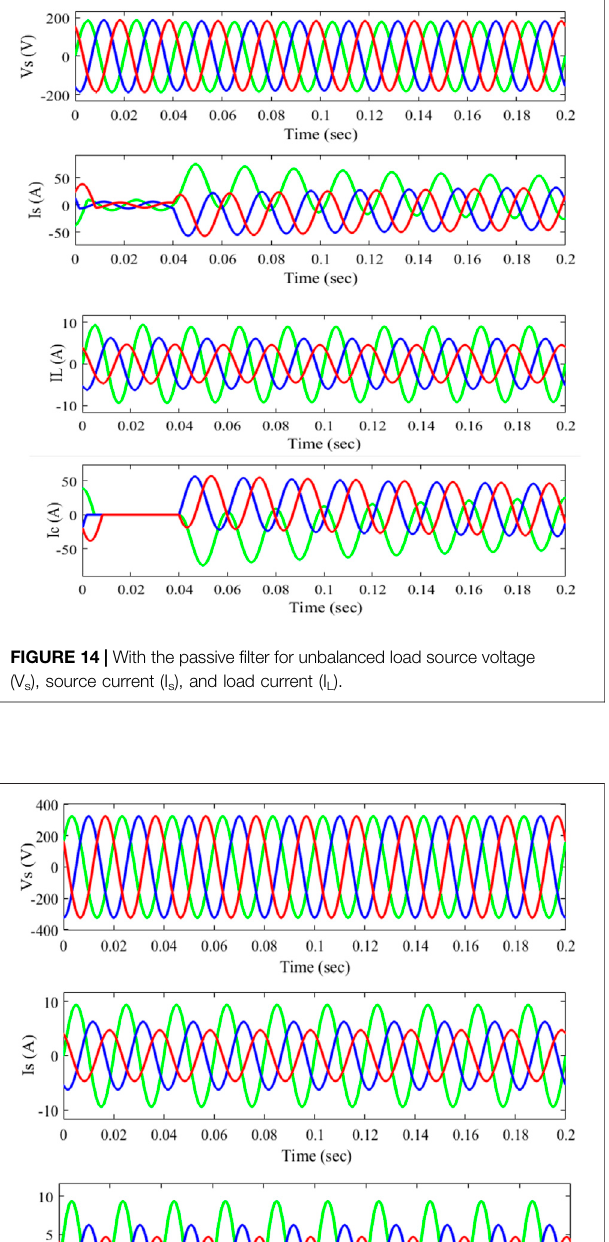
Step 3: A random location is created from the Search agent. Step 4: The fi tness values of Gray wolves are computed using an objective function.